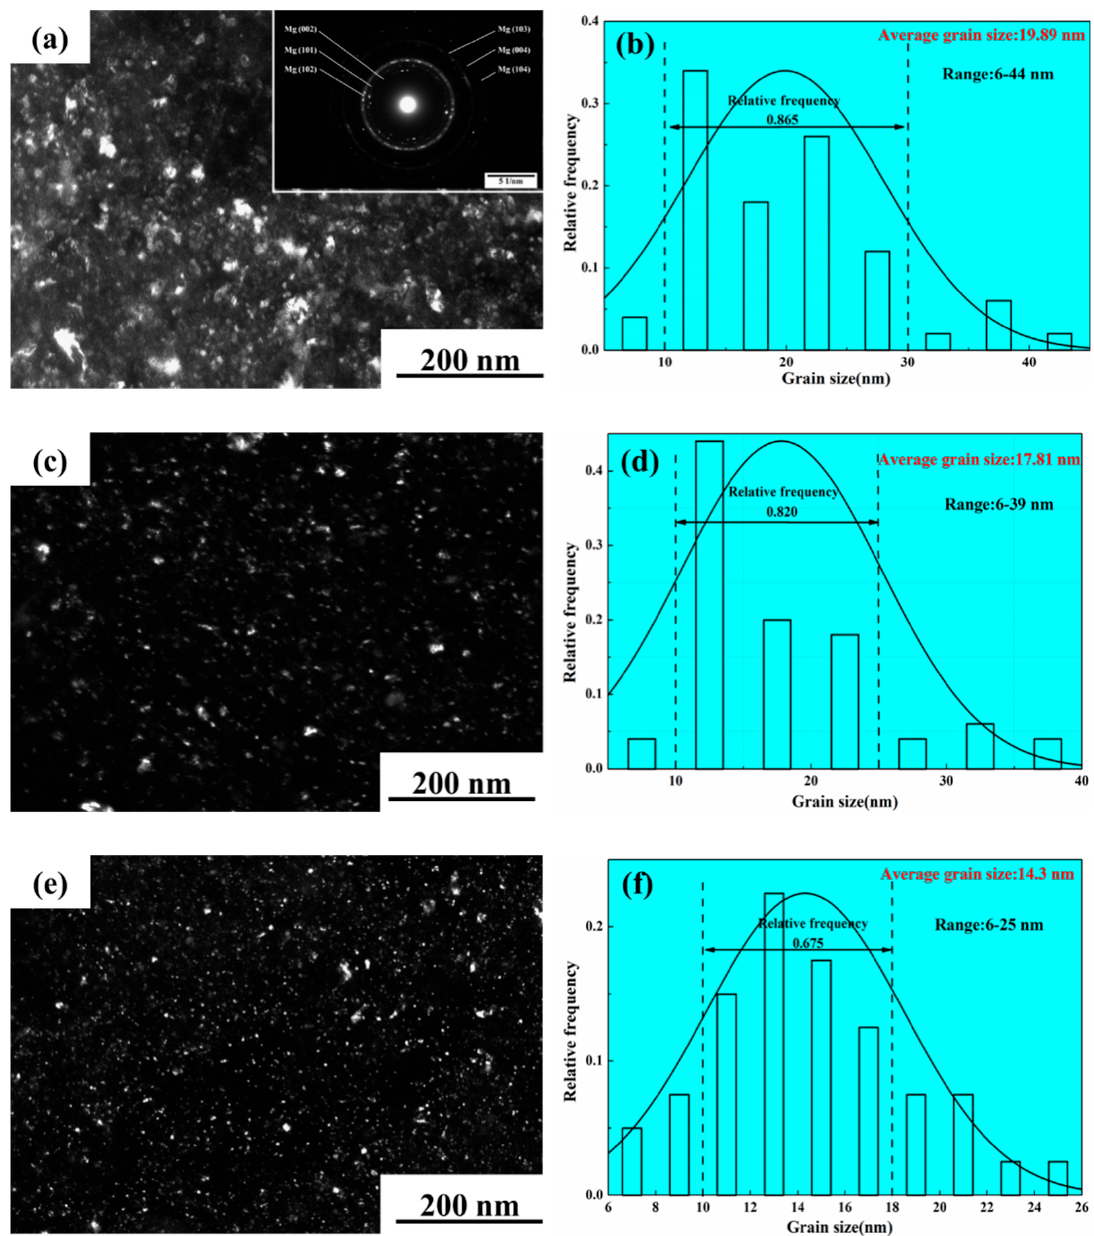
Figure 8. TEM images and corresponding grain size distribution maps of AZ31–V P powders with different V P contents after milling for 90 h: ( a , b ) 5 wt %, ( c , d ) 7.5 wt %, and ( e , f ) 10 wt %.